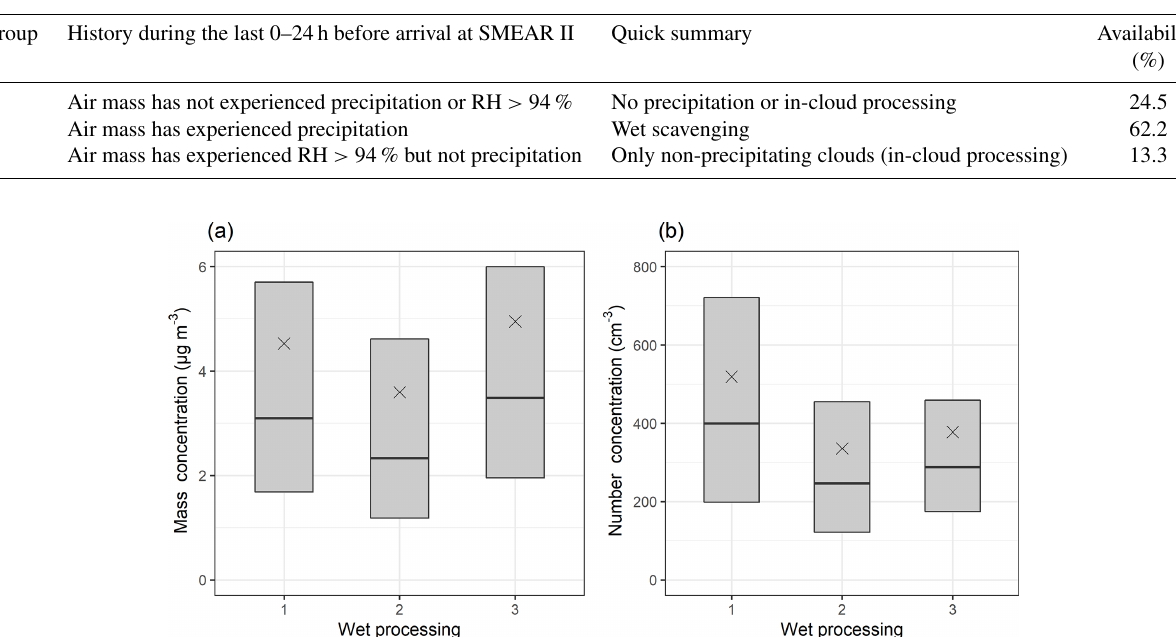
Table 1. Definitions for the wet processing groups. Availability shows the percentage of trajectories relative to total number of trajectories belonging to the wet processing groups. Definitions are according to description of explained quantities in Sect. 2.2.